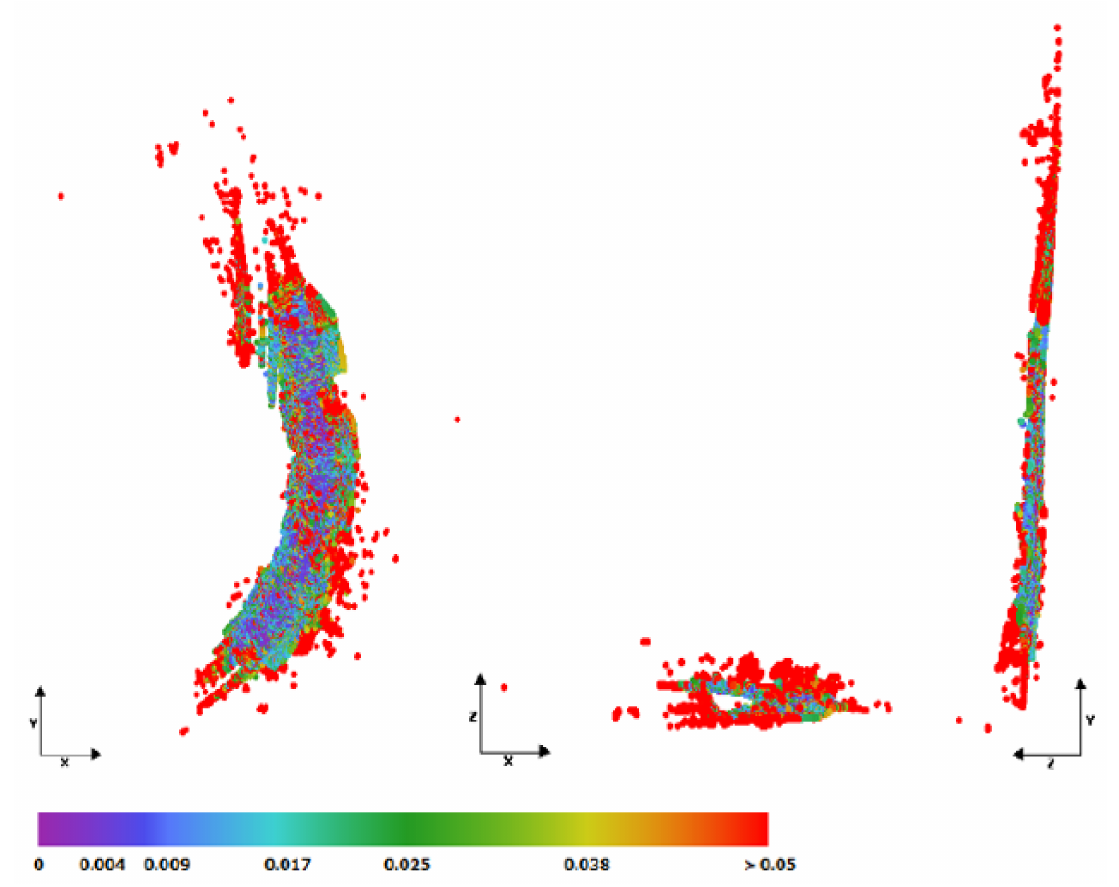
Figure 8. Uncertainty at tie points